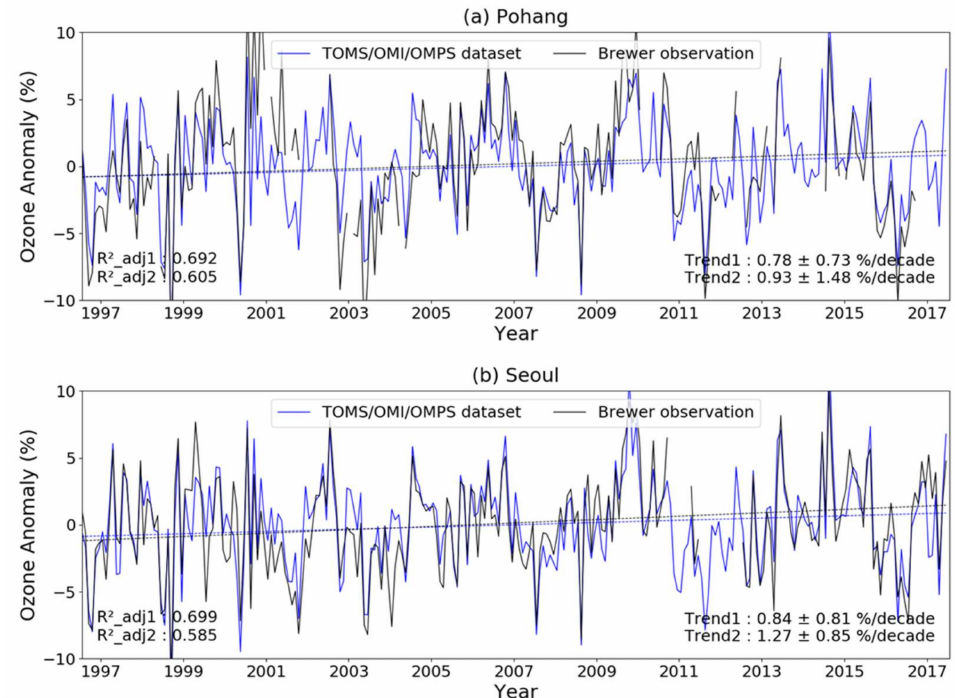
Figure 8. Time-series of the monthly total column ozone from the TOMS/OMI/OMPS dataset and Brewer spectrophotometer in Pohang ( a ) and Seoul ( b ). The TOMS/OMI/OMPS dataset is indicated as blue lines and corresponds to Trend1 and R 2 _adj1, while the Brewer observation data are indicated as black lines and correspond to Trend2 and R 2 _adj2. The dotted line denotes the trend derived through the MLR analysis based on each